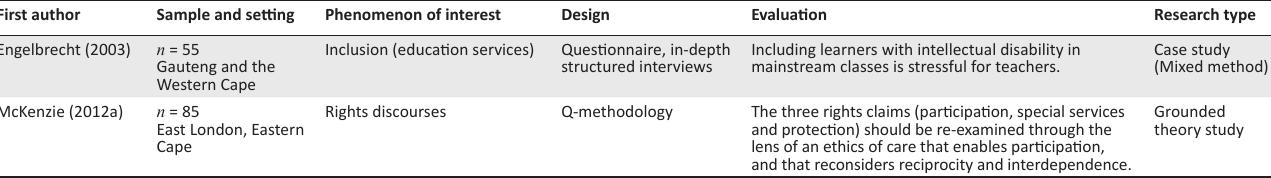
TABLE 3b: Examples of data extraction forms – Sample, Phenomenon of Interest, Design, Evaluation, Research: For qualitative